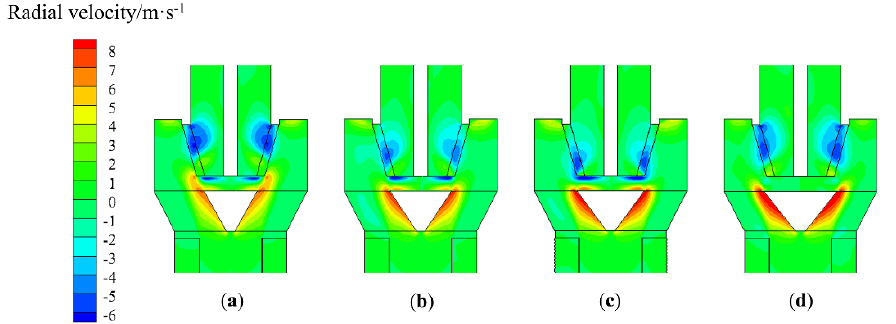
Figure 25. Effect of the diameter of the diversion cone on the radial velocity (T-D (1-0.7) , x = 0): ( a ) d = 154 mm, ( b ) d = 173.3 mm, ( c ) d = 192.5 mm, and ( d ) d = 211.7 mm.